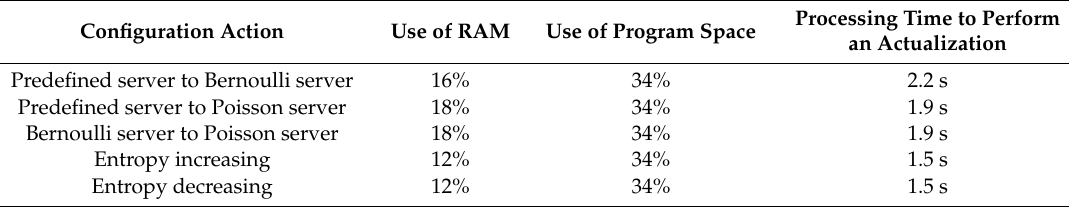
Table 9. Fourth experiment: